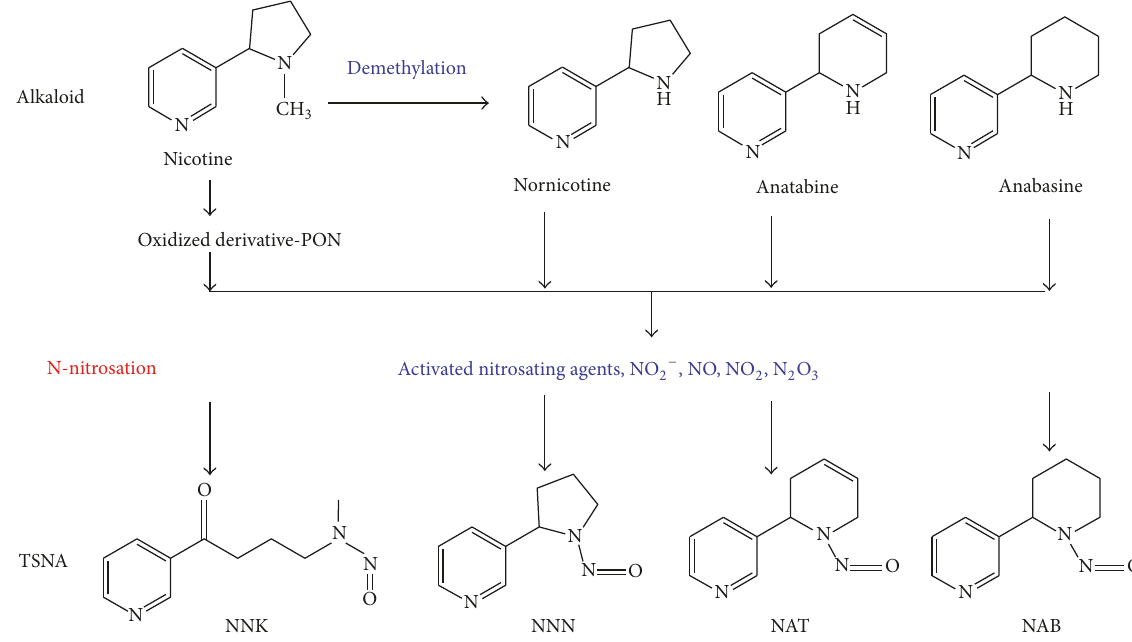
Figure 1: Proposed formation pathways of the major TSNAs found in cured tobacco leaves. Nitrosating agents can directly interact with nornicotine, anatabine, and anabasine to form NNN, NAT, and NAB, respectively. Nicotine is less susceptible to nitrosation; thus NNK is produced from pseudo-oxynicotine, an oxidized derivative of nicotine.